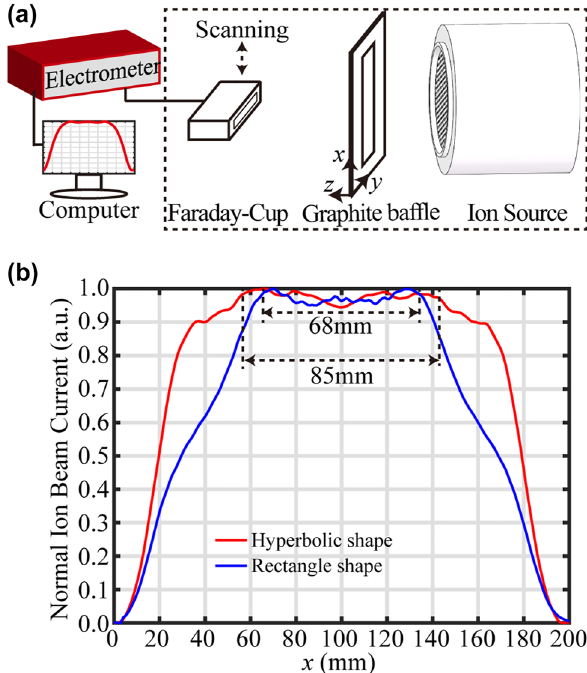
Figure 5: Density distribution of the ion-beam. (a) Method to test the ion-beam density distribution. The region enclosed by the dashed line was inside a vacuum chamber. (b) Distribution curves of ion-beam density for graphite baffles with the rectangular and hyperbolic shape